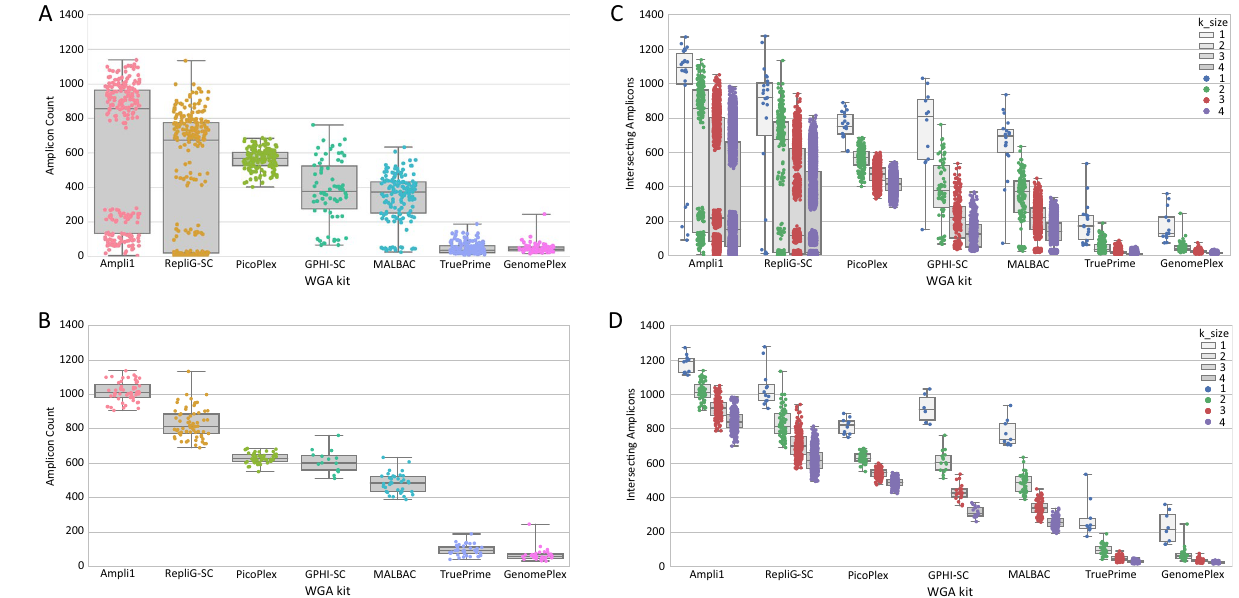
Figure 2. scWGA reproducibility analysis. ( A ) Each pair of cells (k = 2) per scWGA kit were analyzed for the number of mapped amplicons that were mapped in both cells. Each dot represents a pair of cells, y-axis is the number of amplicons which were mapped by > 0 reads that worked for both cells (intersecting amplicons). ( B ) Same analysis as in ( A ) but for the upper median of the most successful cells as reflected by their number of amplifying amplicons (Fig. 1). ( C , D ) Same analysis as in ( A ) and ( B ), respectively for cell groups comprised of k = 1 to k = 4 cells (k = 1 is the same as presented in Fig. 1, k = 2 is the same as presented in ( A ) and ( B ). Repeated presentation is for visualization of results in the context of all group